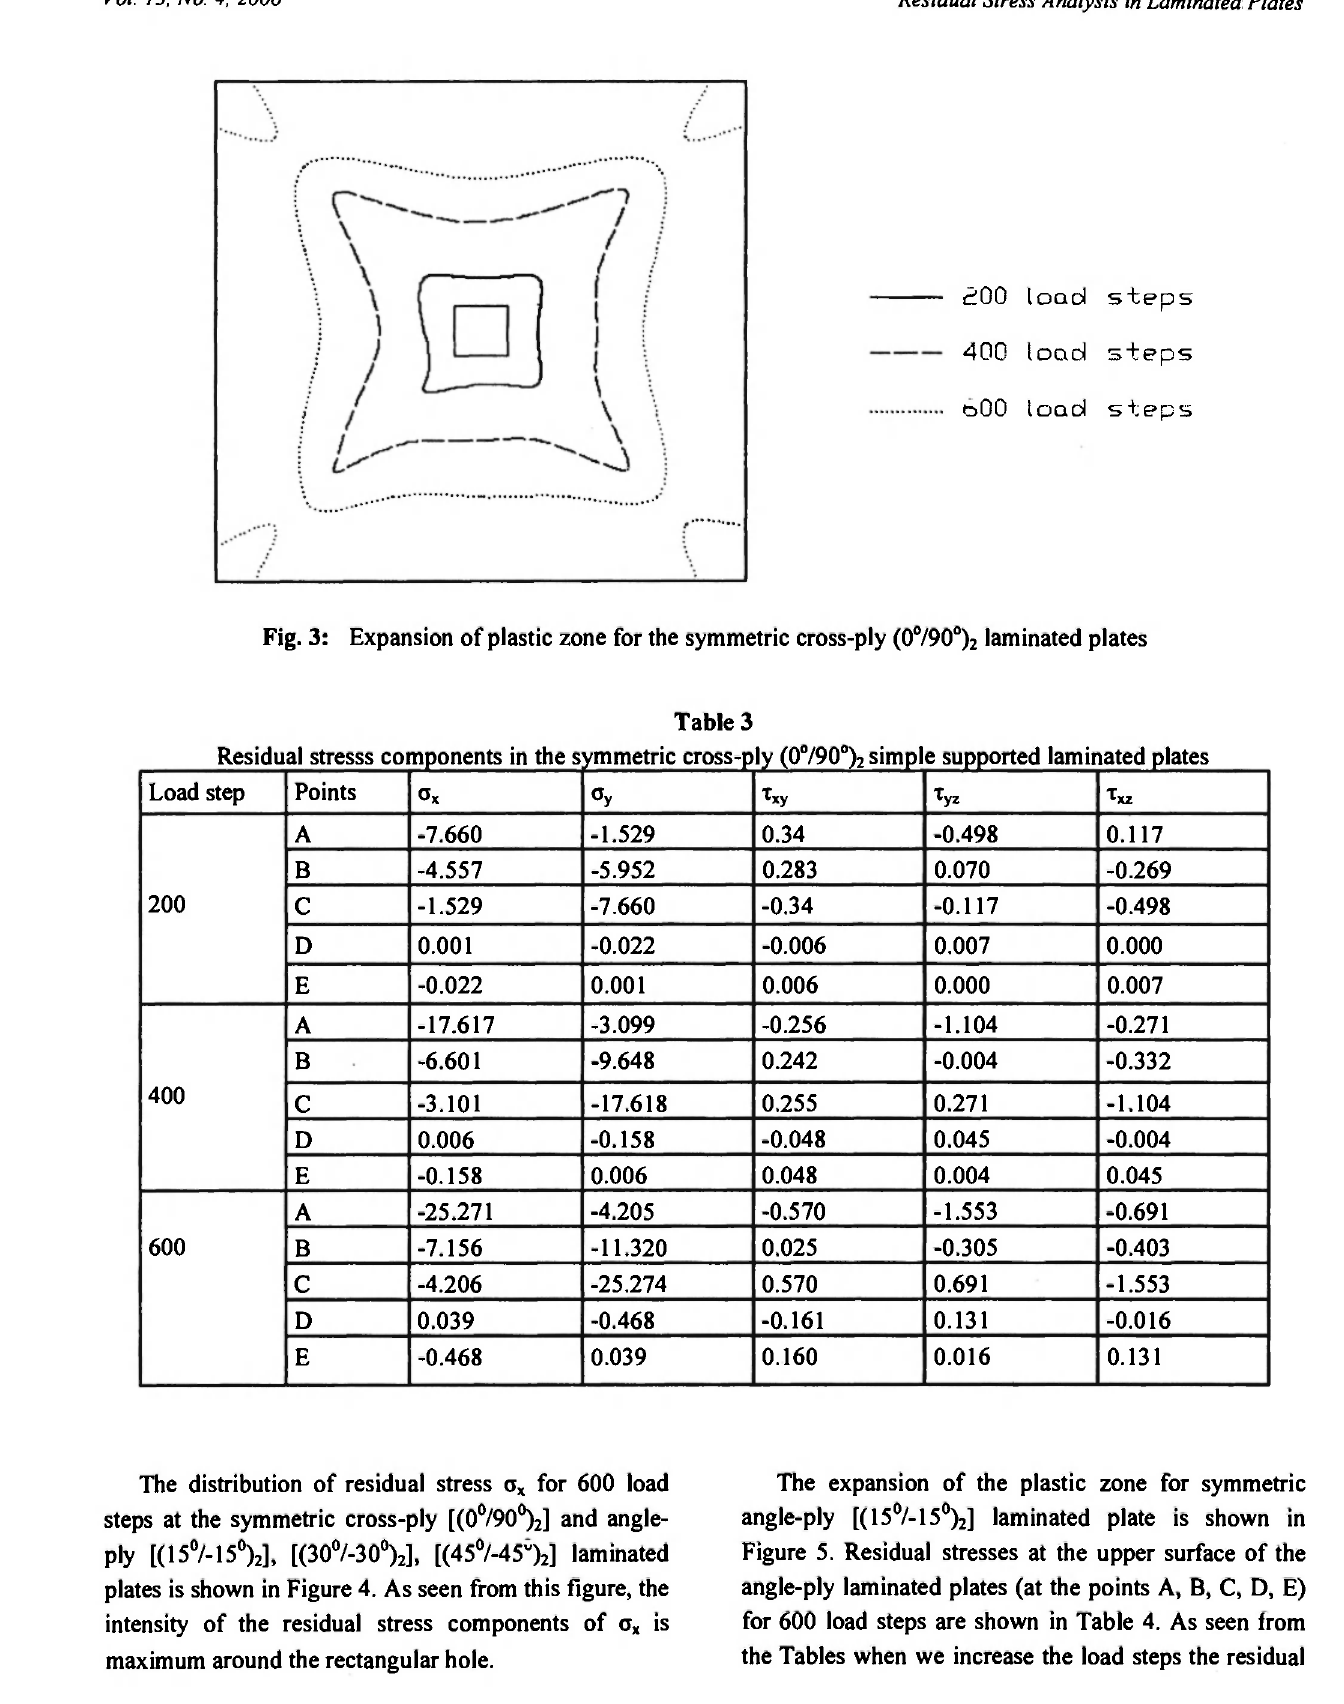
Figure 5. Residual stresses at the upper surface of